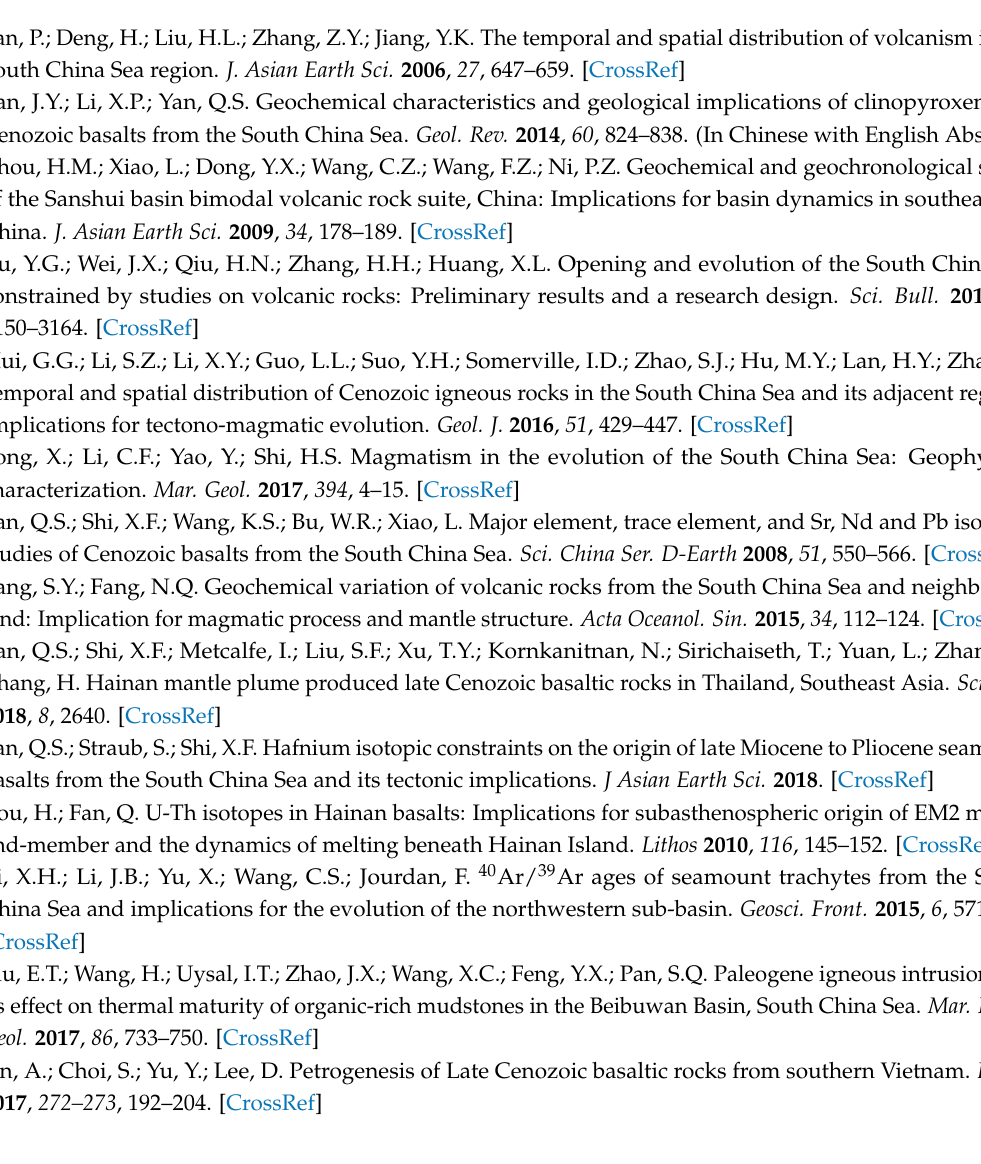
individual crystal. Table S2: The LA-ICP-MS analyses of the clinopyroxenes in sample zr1h. Each sample name represents an individual crystal. Table S3: Major element compositions of clinopyroxenes from the basaltic pyroclastic rocks. Calculations are based on 6 oxygens. The data were processed with the geochemical software tool, “Geokit”. Each sample name represents an individual crystal. Table S4: Trace element and REE compositions of the clinopyroxenes from the basaltic pyroclastic rocks. Each sample name represents an individual crystal. Table S5: The calculated melt of the basaltic pyroclastic rocks from Well